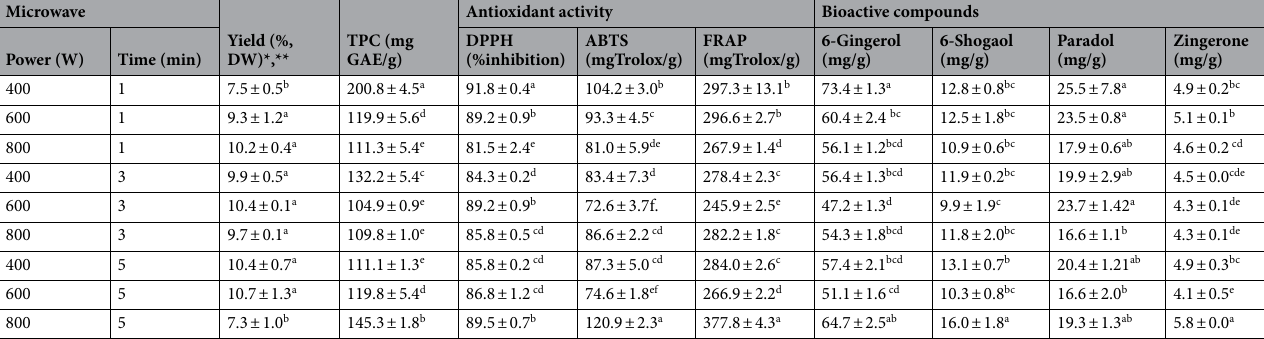
Table 1. Operation parameters and responses for microwave-assisted ginger extraction by 3 2 full factorial design. *DW means dry weight. **a-f represented the significant difference in the columns at p < 0.05.